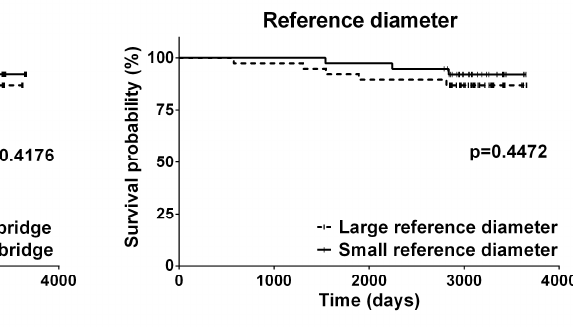
Table 2. Summary of univariate and multivariate Cox regression analysis of overall survival in over- all population and LAD-MBneg group.